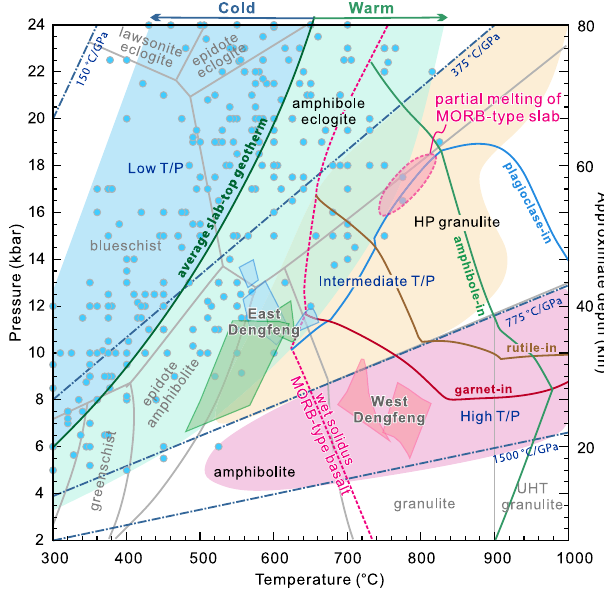
Fig. 7 | Partial melting P – T conditions in the Angou Complex. Phase diagram showing that the melting P – T conditions for generating adakitic magmas partially overlap with the slab-top P – T conditions (blue and green areas) from Neoproter- ozoic to present subduction zones, reconstructed from exhumed metamorphic rocks (blue circles) in orogenic belts 51 (modi fi ed from ref. 22). The boundaries of wetsolidusandkeyphases(garnet,amphibole,plagioclase,andrutile)areoutlined, andwerecalculatedbasedontheaverageMORBprotolith(MORB-AV)intheAngou Complex. Note that cold and average slab-top geotherms do not intersect the wet solidusofbasalt.The P – T conditionsoftheArcheanDengfengpairedmetamorphic belt are also shown 22